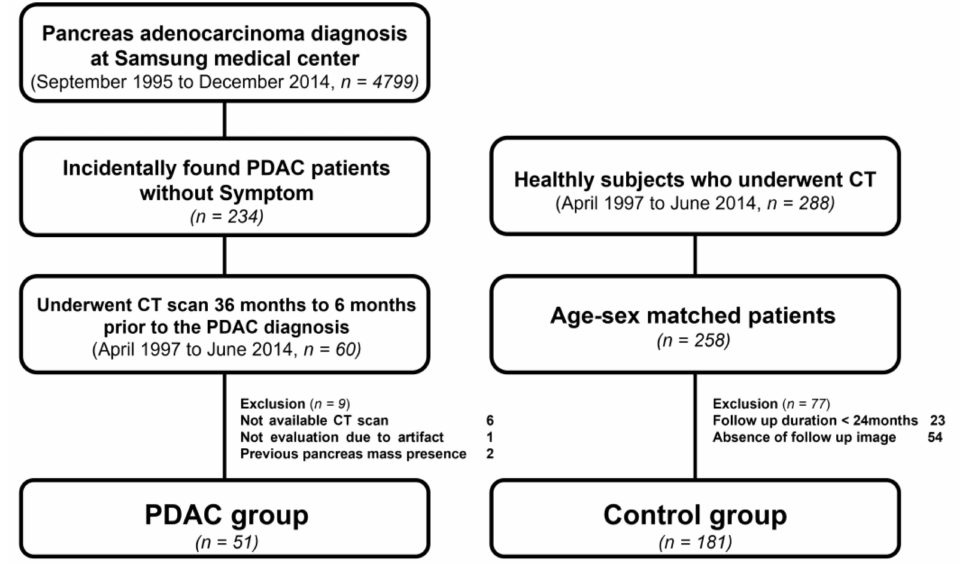
Figure 1. Study design and patients